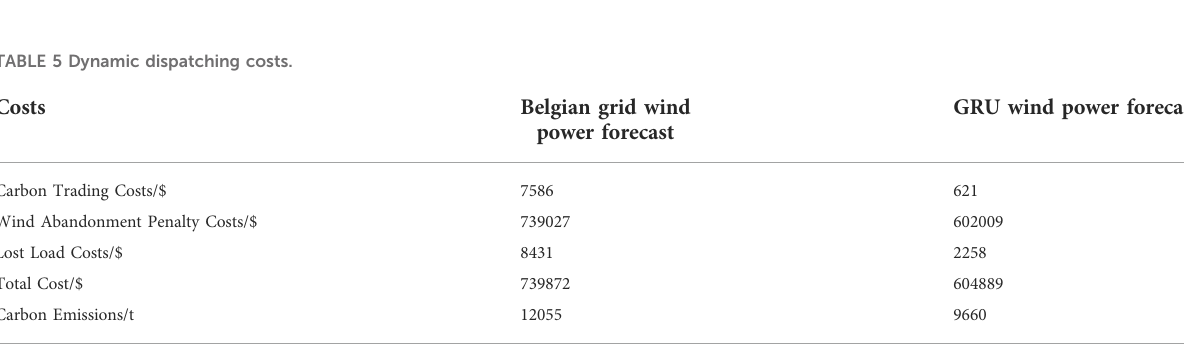
TABLE 5 Dynamic dispatching